Question: What visual encoding does this figure use to show its data?
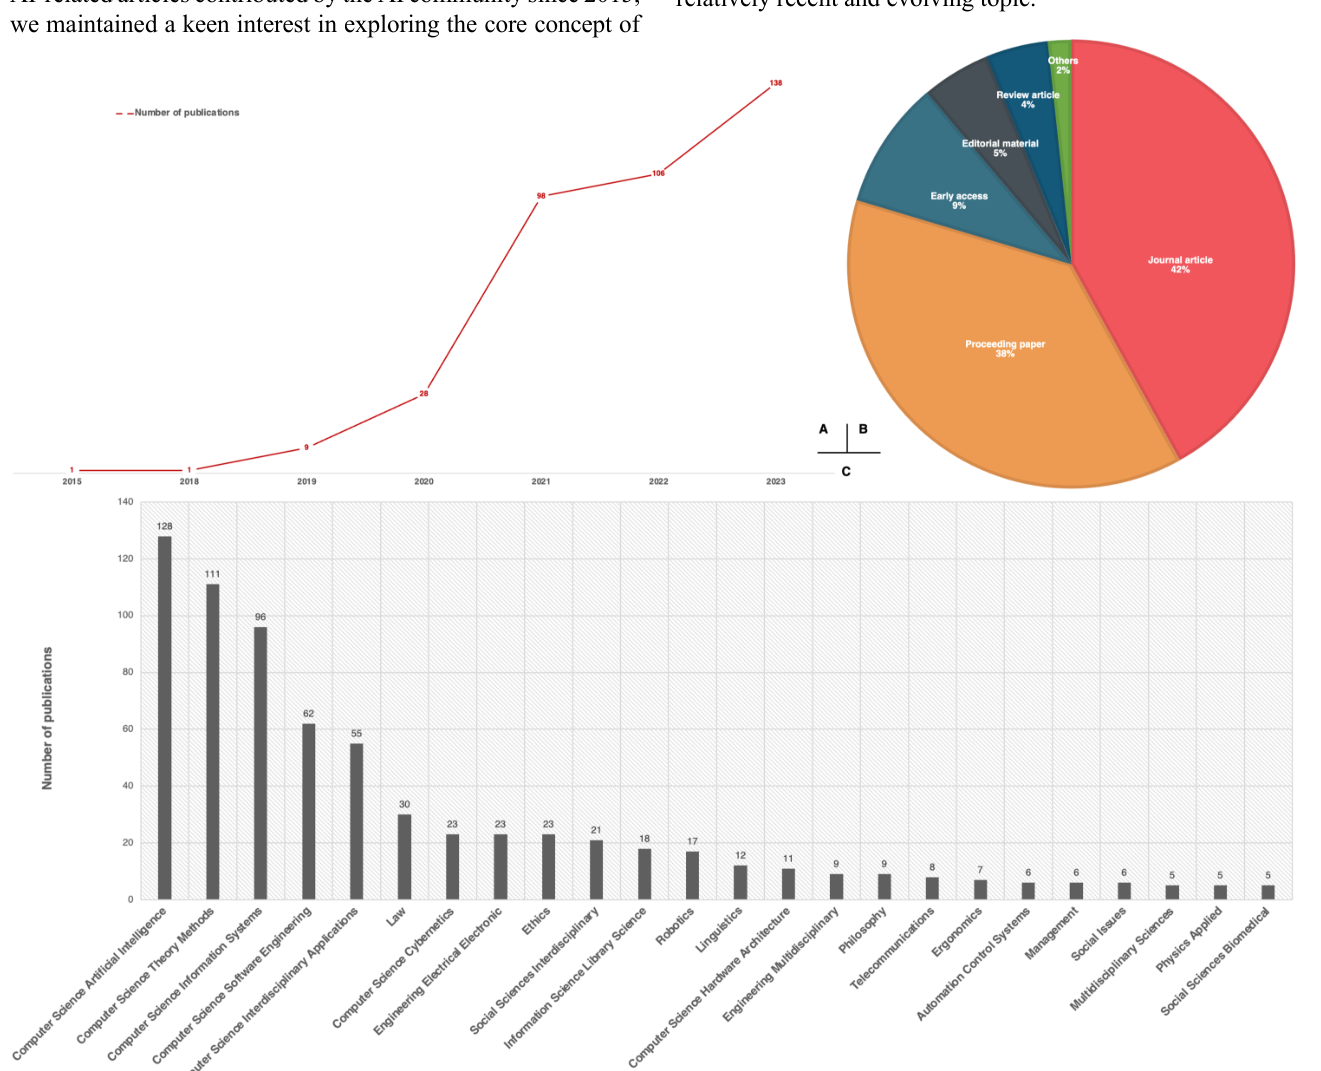
Answer: line